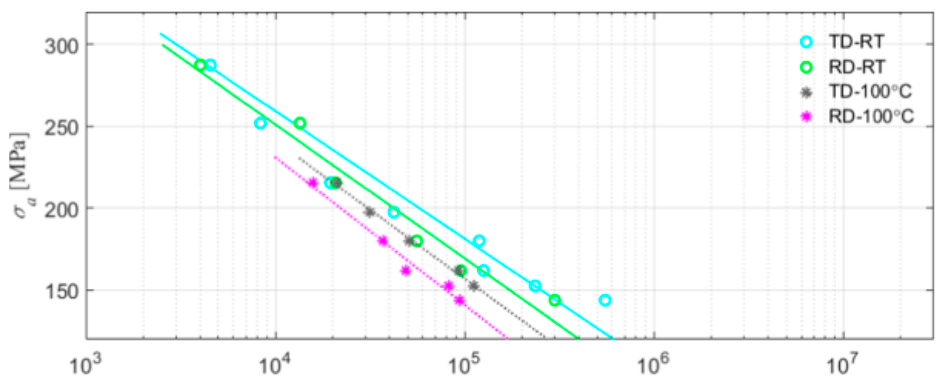
Figure 15. S-N curves for samples of WE43-T5 along rolling (RD) and transverse (TD) directions at different temperatures, including room and 100 °C “Reused with permission from Elsevier by License No. 5494640717153” [138].